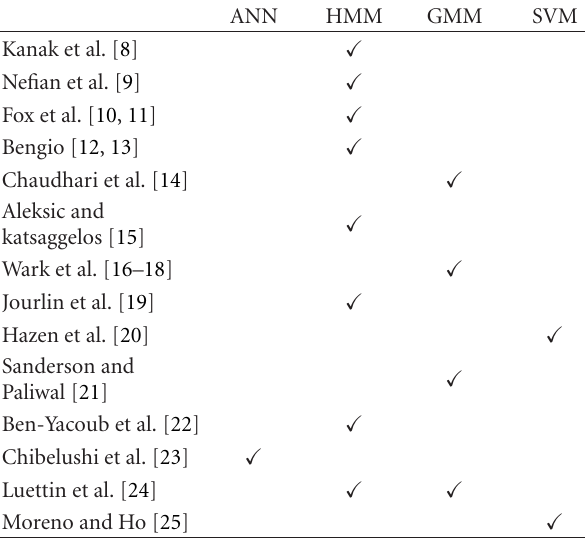
Table 1: Classification algorithms where majority of research works on voice classification